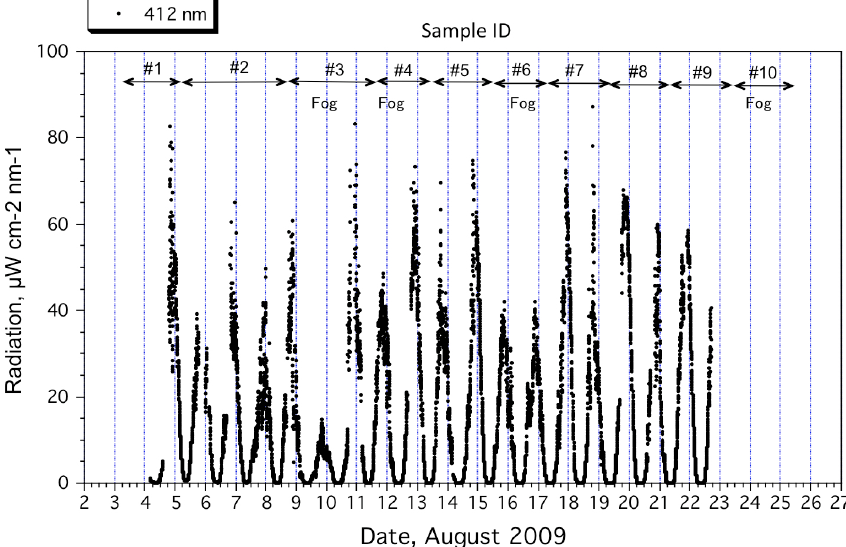
Fig. 2. Solar irradiance at UV 412nm and aerosol filter ID with information of fog event.